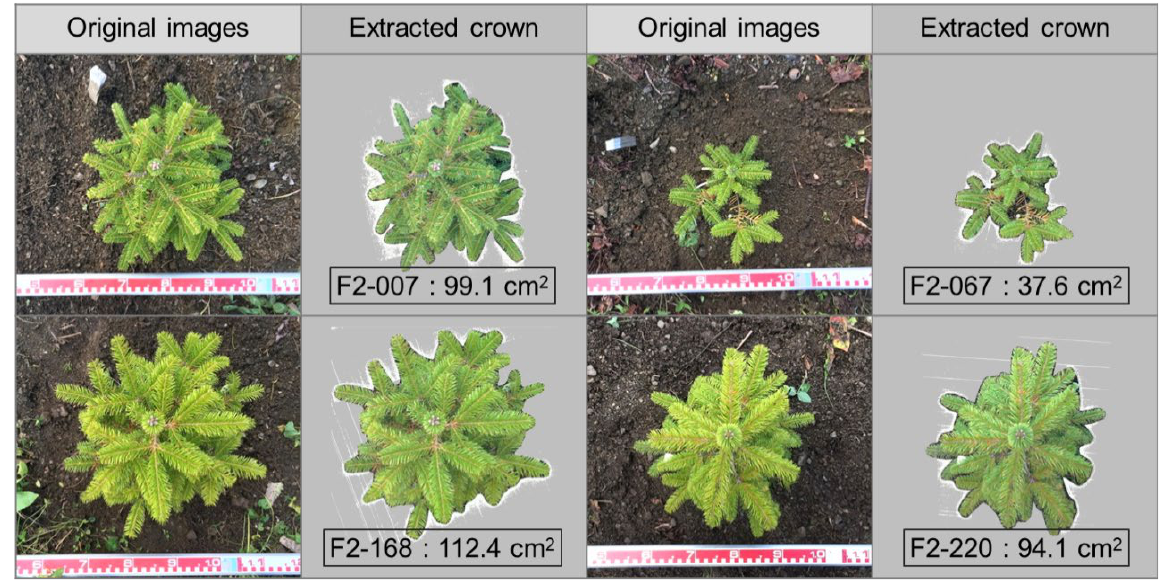
Figure 1. The original images taken via photograph-based projection ( left ) and the images of the individual plants with the calculated crown area based on the scale ( right ).